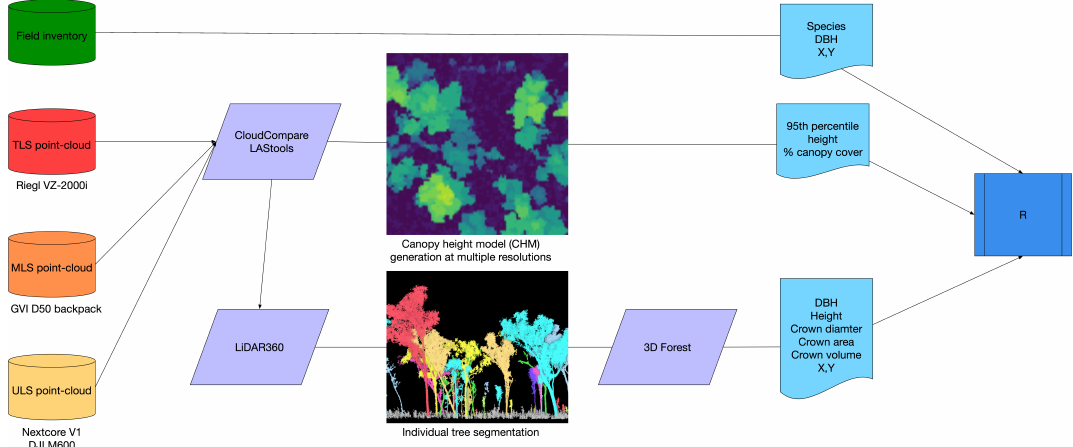
Figure 4. Overview of the processing workflow and software packages used at different stages of